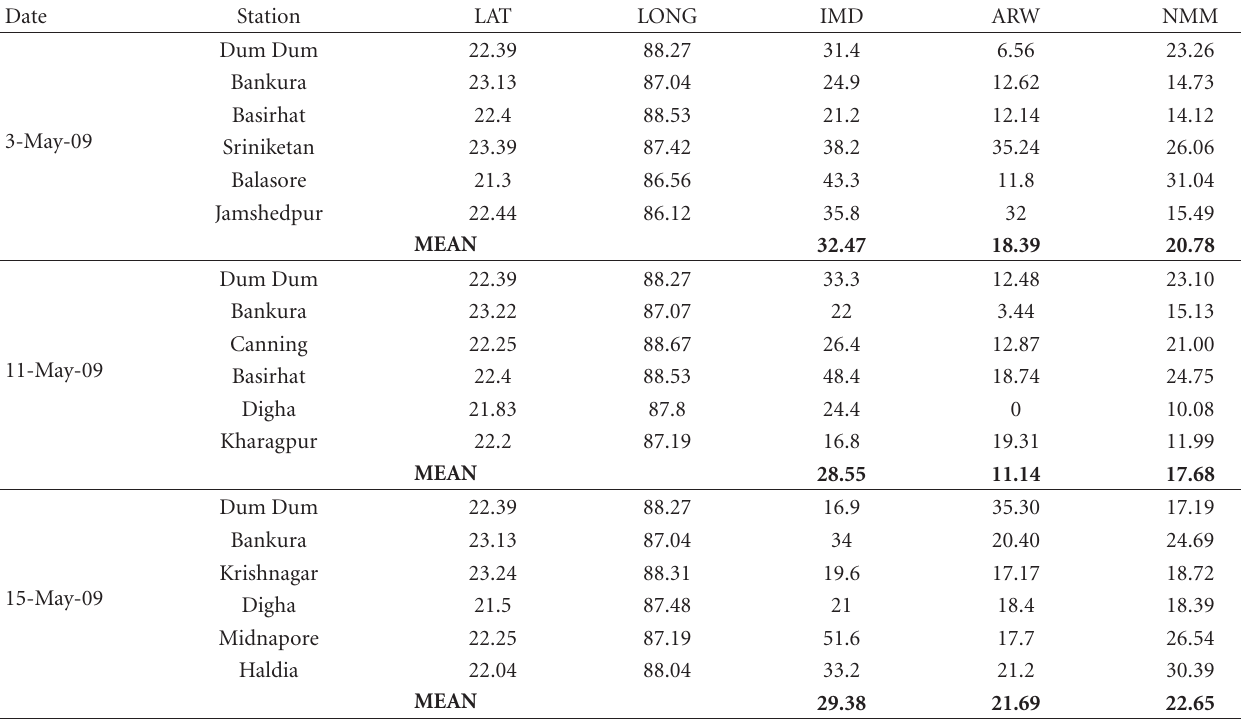
Table 4: Comparison of modeled precipitation of three thunderstorm cases with rain gauge observations.